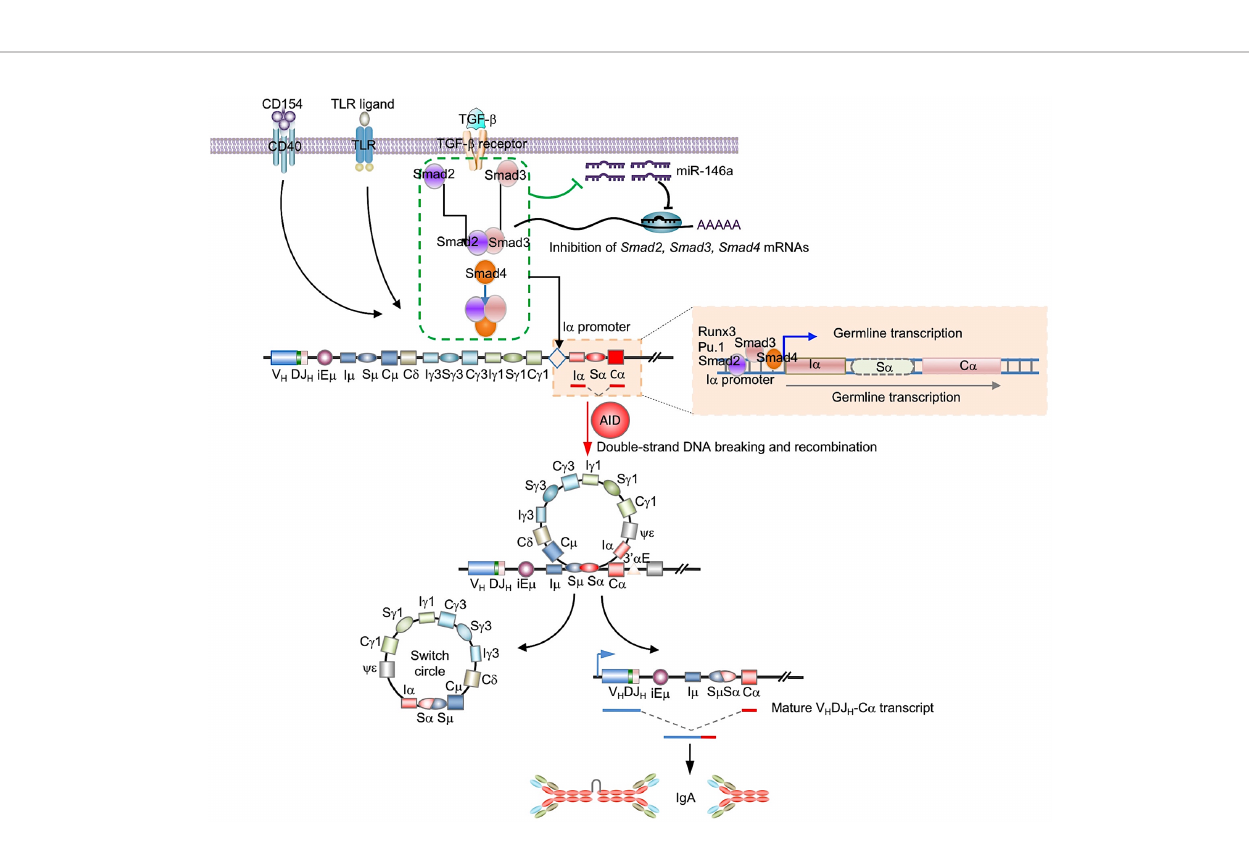
FIGURE 10 | Epigenetic regulation of CSR to IgA by miR-146a. miR-146a targets the 3 ’ UTRs of Smad2 , Smad3 and Smad4 mRNAs to downregulate the expression of Smad2, Smad3 and Smad4, and reduce germline I a -C a transcription leading to a decreased CSR to IgA and IgA production. In B cells stimulation by TGF- b , activated Smad proteins lead to miR-146 reduction, which results in enhancement of expression of Smad proteins themselves. This miR-146a/Smad loop can amplify TGF- b -induced Smads promotion of CSR to